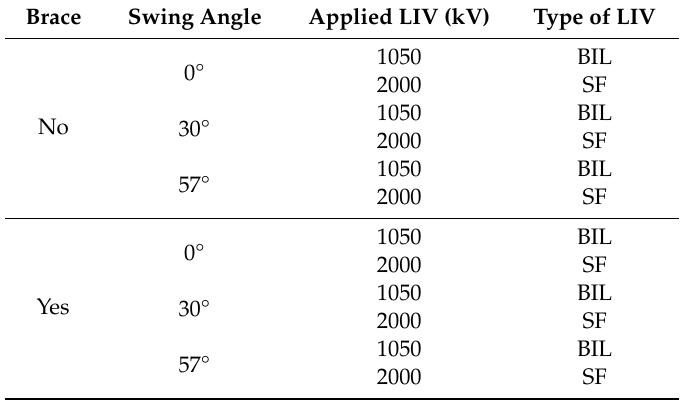
Table 3. Simulations